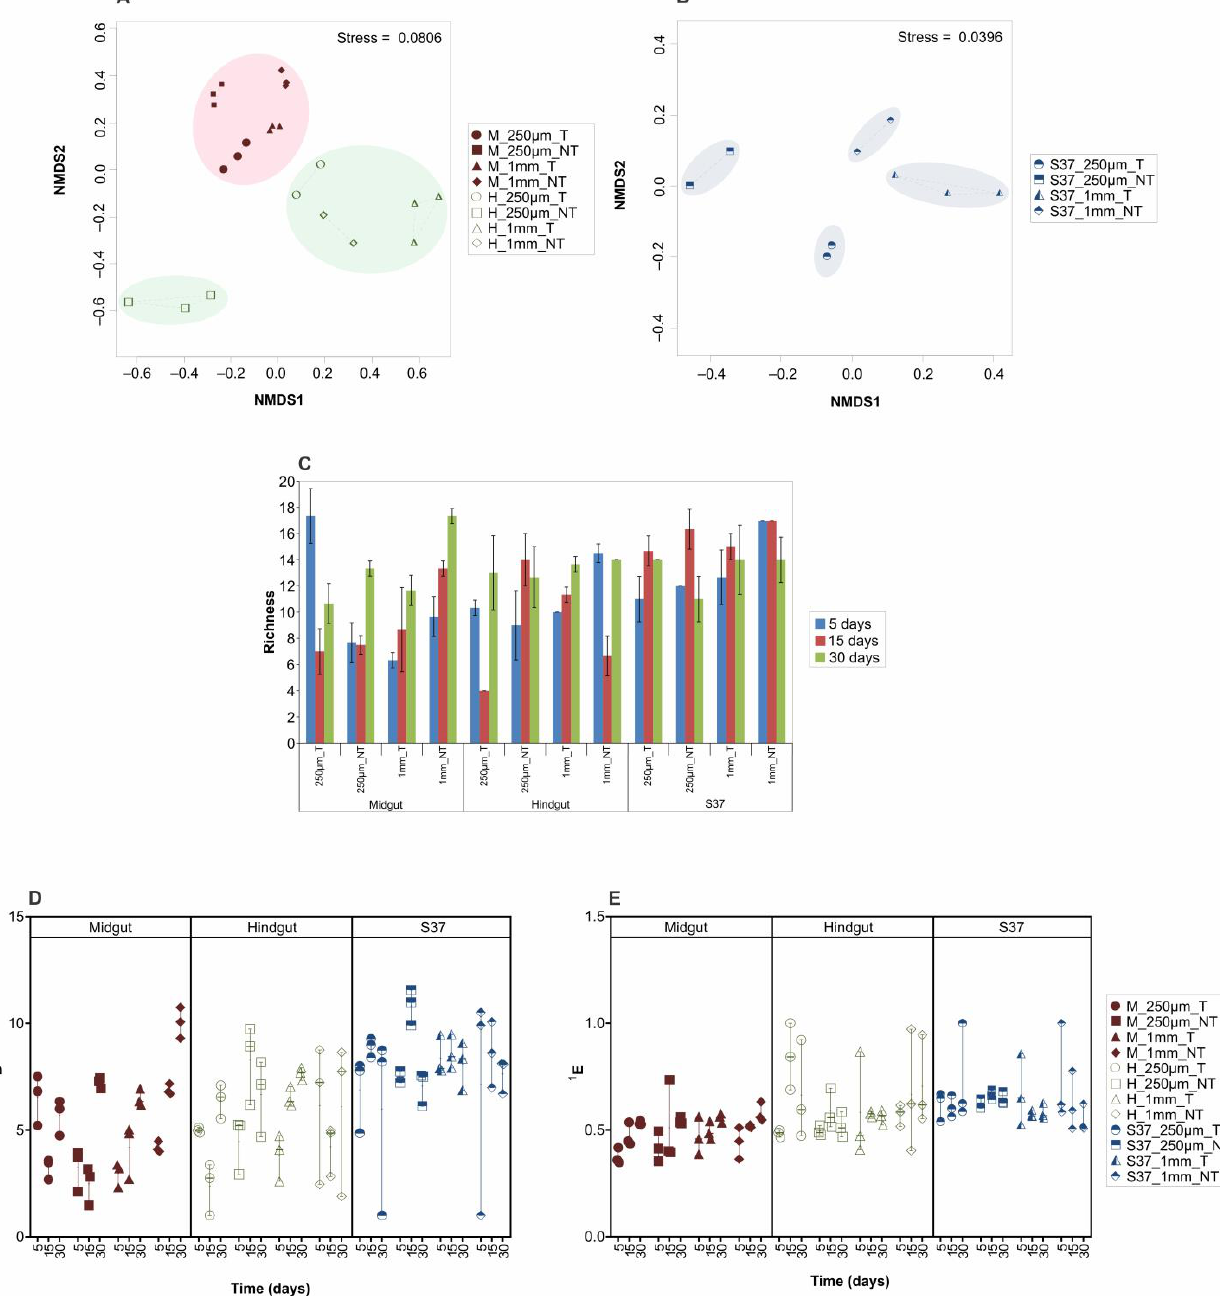
Figure 4. Bacterial community dynamics and diversity. The non-metric multidimensional scaling (NMDS) plot of T-RFLP profiles of bacterial 16S rRNA gene amplicons obtained with restriction enzyme RSa I. Plot based on Bray – Curtis dissimilarity index showing the similarity relationships of the ( A ) midgut and hindgut cultures, ( B ) Szarvas soda lake cultures. Microbial communities at 30 days of cultivation. ( C ) Richness. ( D ) Diversity of order 1. ( E ) Evenness of order 1. Colors and symbols were used to indicate the different cultures as follows: red: midgut, green: hindgut, blue: S37. To differentiate between treatments across cultures the following coding was used: circles symbols: 250µm_T, square symbols: 250µm_NT, triangle symbols: 1mm_T, rotated square symbols: 1mm_NT.